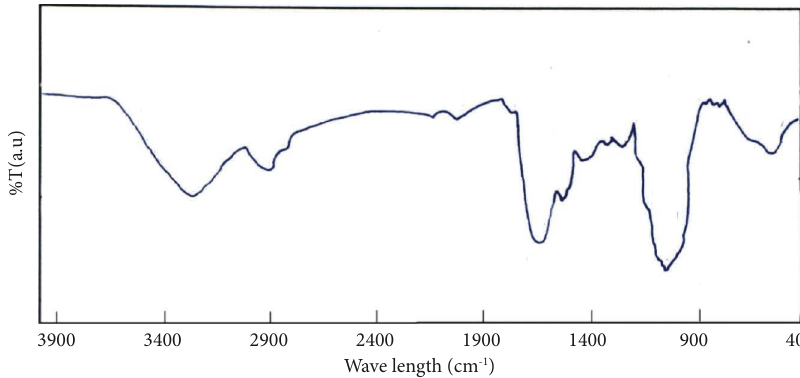
Figure 3: FT-IR spectrum of rapeseed residual biomass.